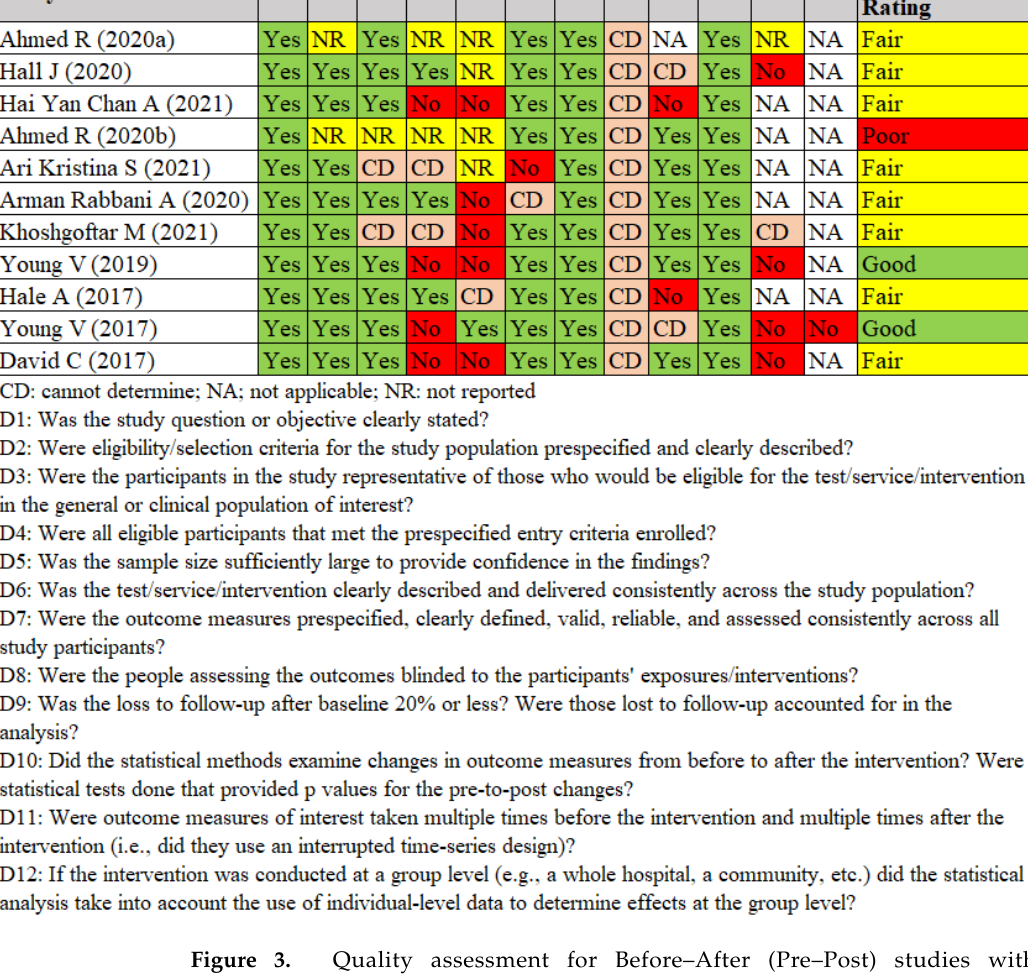
Figure 3. Quality assessment for Before–After (Pre–Post) studies with no control